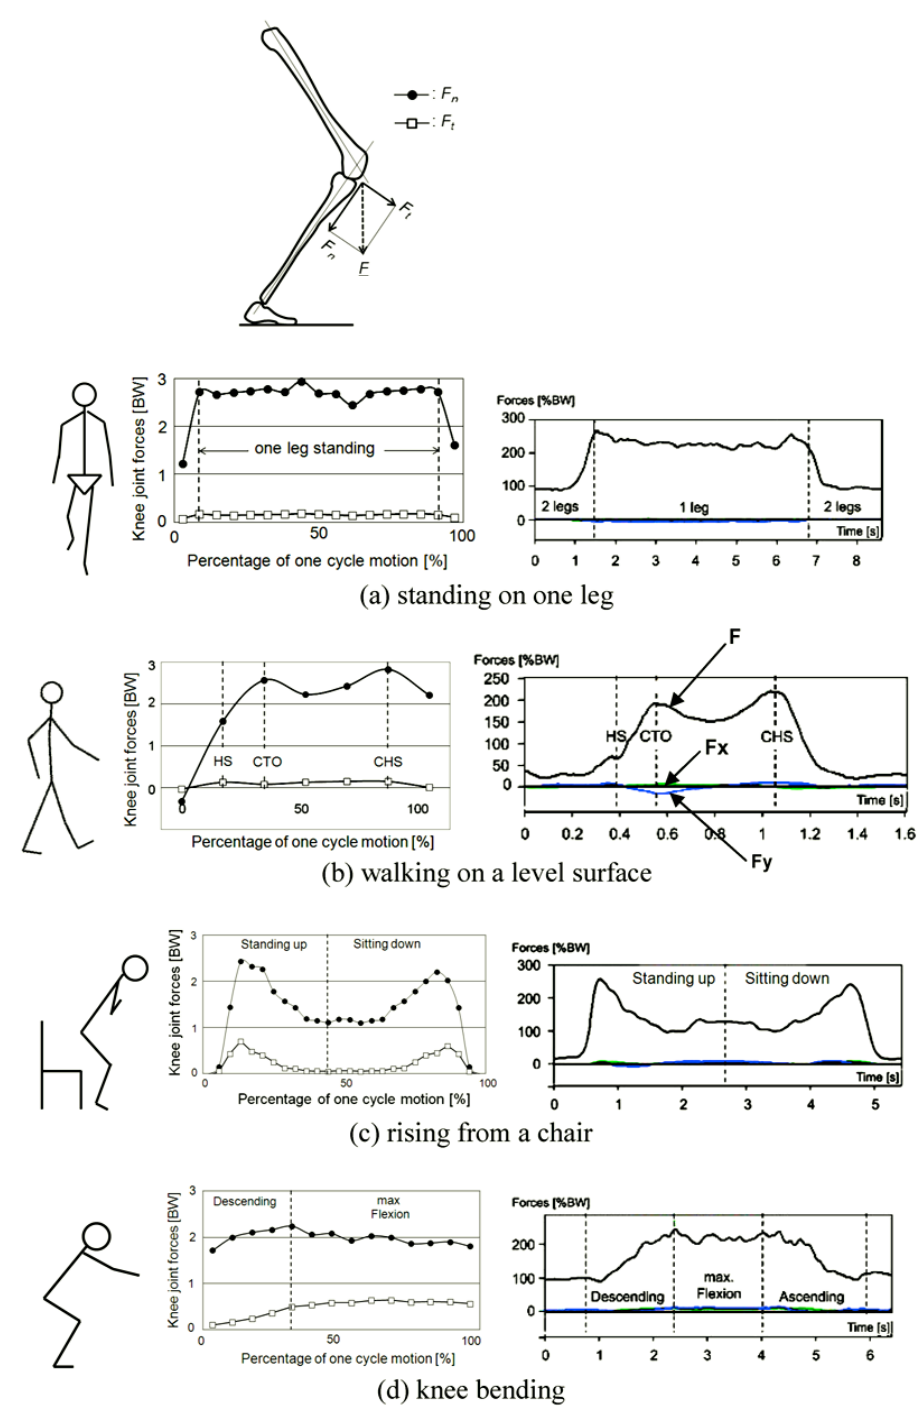
Fig.4 Comparison between knee joint forces from this study (left) and those from the in-vivo measurement (right: modefied those by Kutzner et al. (5) ). (HS: heel strike, CTO: contralateral toe off, CHS: contralateral heel